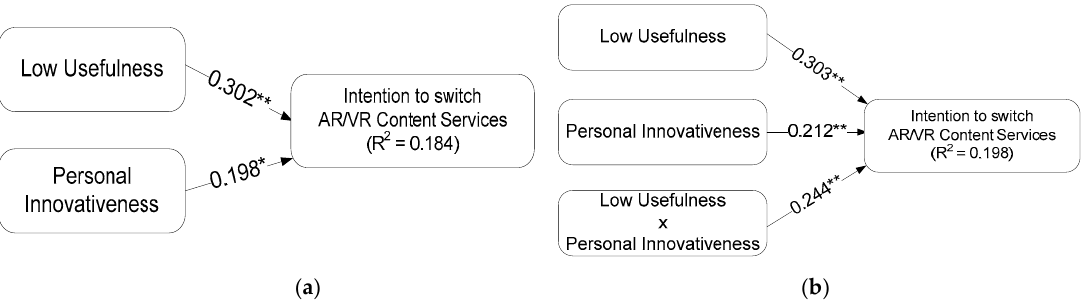
Figure 3. Results of ( a ) the direct effect model and ( b ) the interaction effect model.